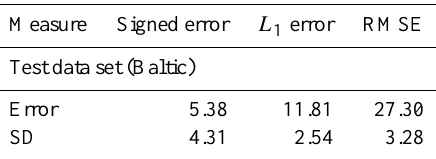
Table 3. Errors for the comparison between FMI ice charts and the ASI results. The same Mercator projection as in the other Baltic Sea comparisons was used.